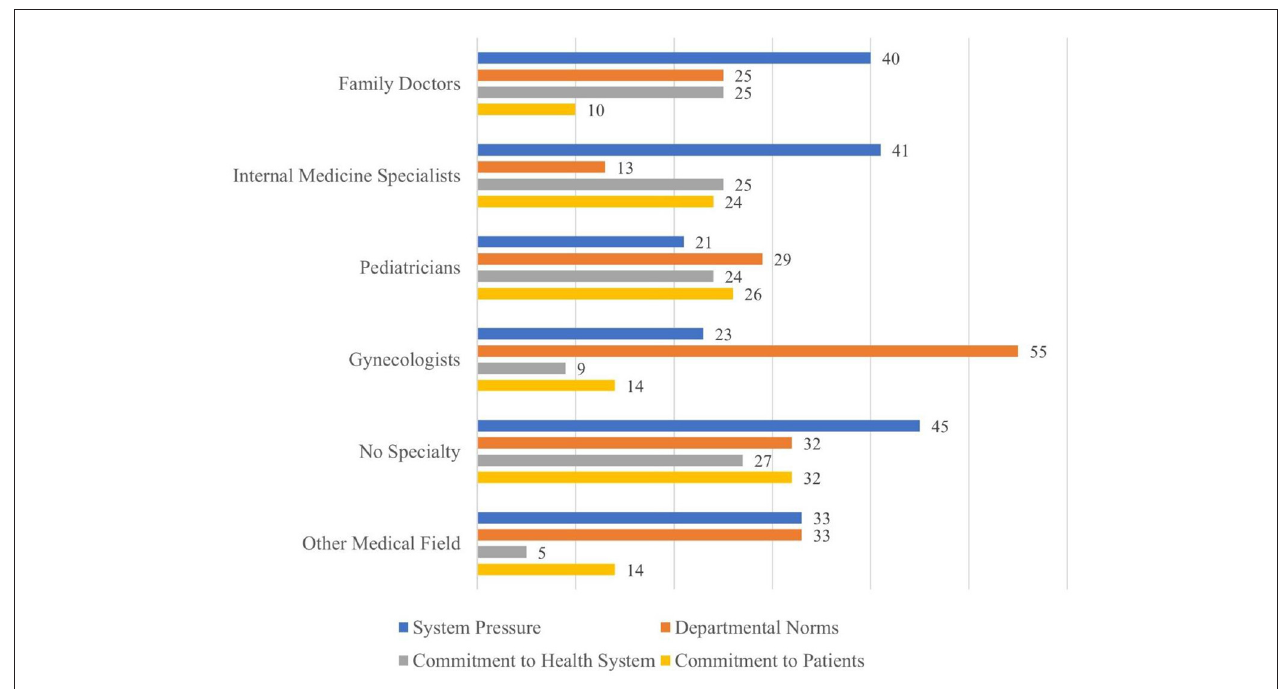
FIGURE 1 | Physician’s reasons for vaccination by area of specialization